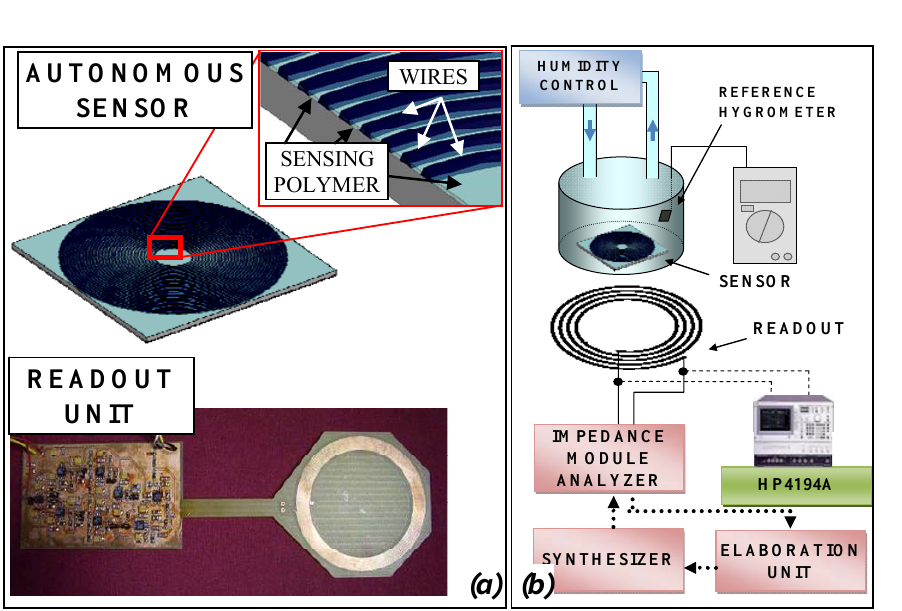
Figure 4. (a) Picture of the passive autonomous sensor and readout system for RH measurement and (b) block diagram of the experimental